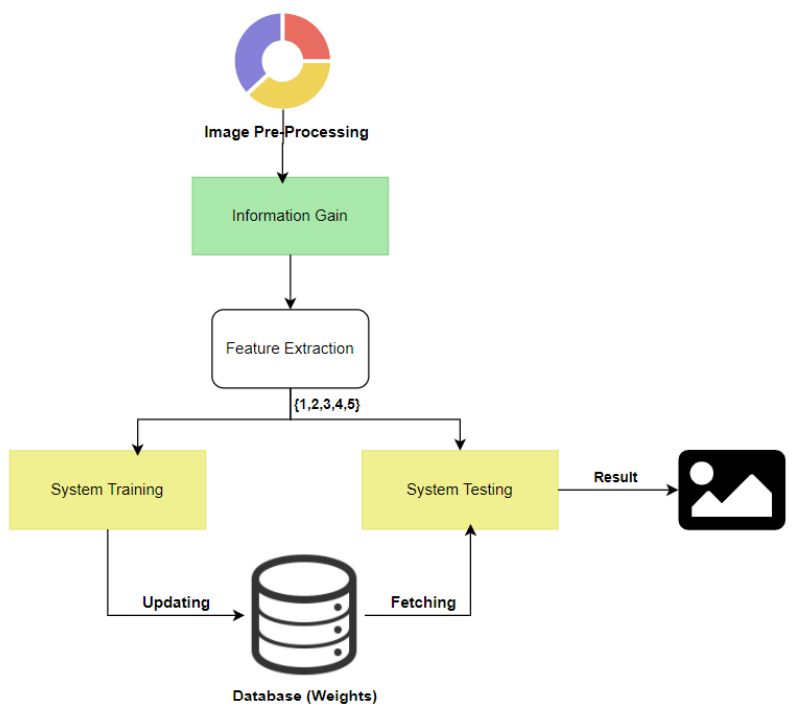
Figure 6. General architecture of the developed hand gesture detection system. Table 2. Model Summary.